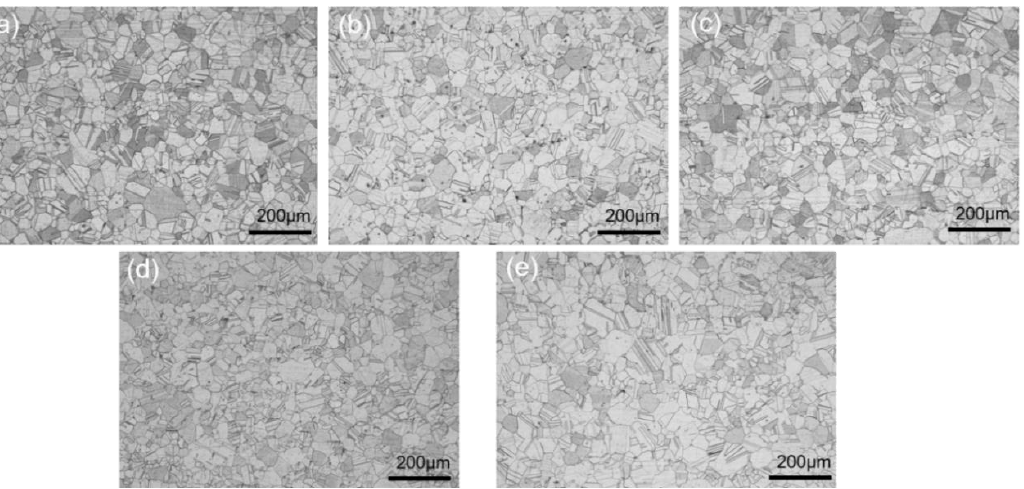
Figure 3. OM of the GH3625 superalloy at 1050 °C for various times: ( a ) 5 min; ( b ) 15 min; ( c ) 30 min; ( d ) 45 min; ( e ) 60 min.